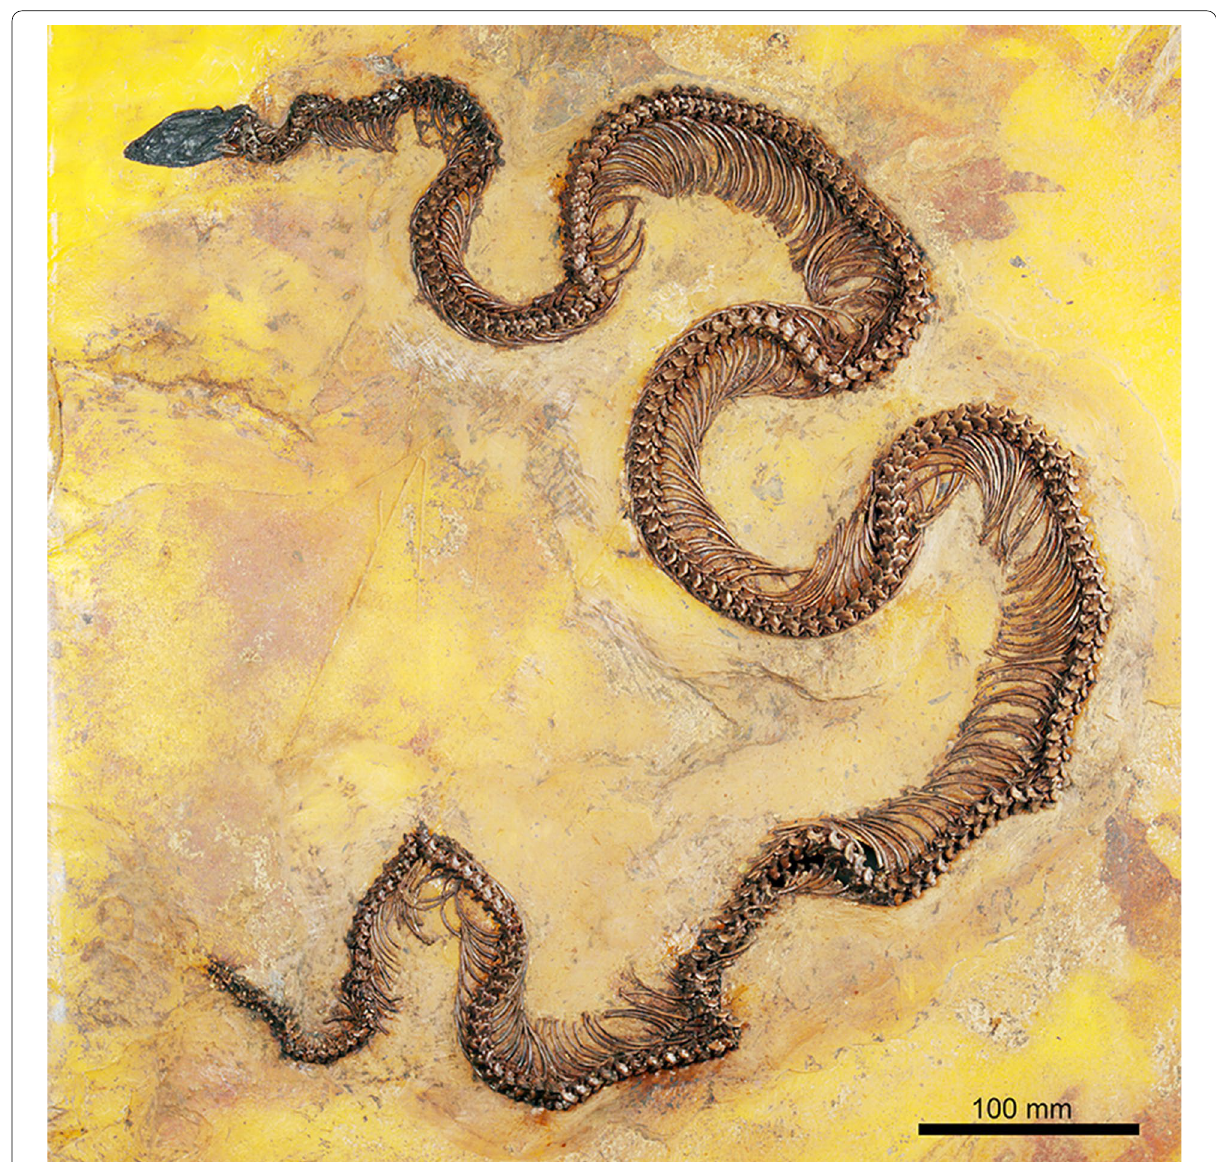
Fig. 51 Eoconstrictor fischeri from Messel: complete, 201 cm long, skeleton with skull (SMF-ME 1607). Specimen was originally figured by Keller and Schaal (1988:fig. 194) and Schaal (2004:fig.